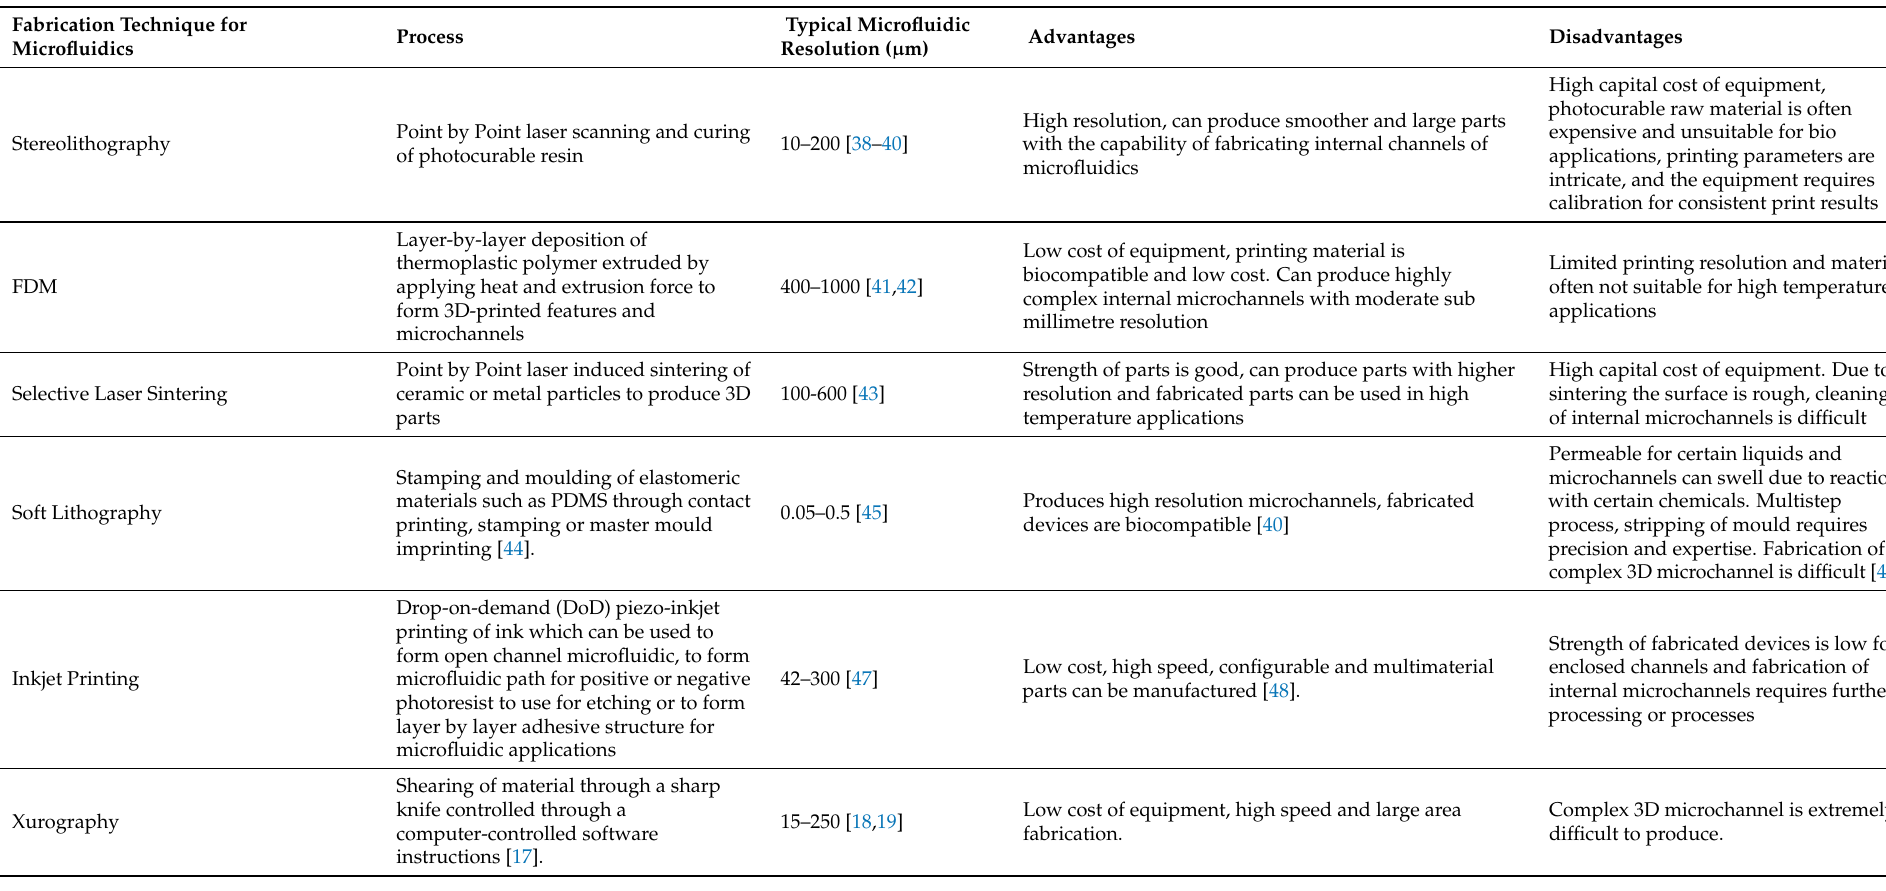
Table 1. Comparison of prominent additive manufacturing and other microfluidic fabrication